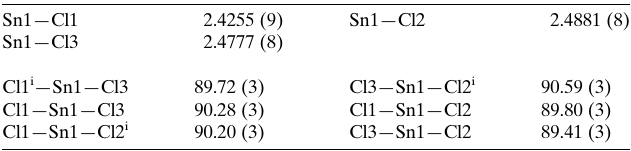
Table 1 Selected geometric parameters (A˚ , (cid:2) ).